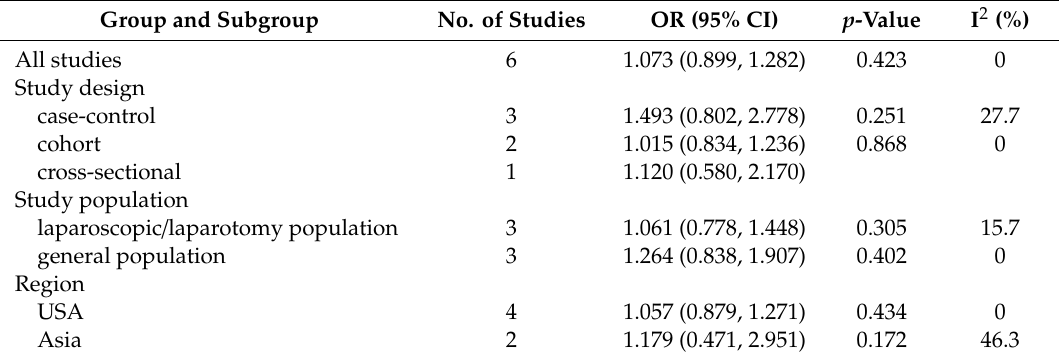
Table 5. Results of the meta-analyses of studies of the association between monoethyl phthalate (MEP) and endometriosis.